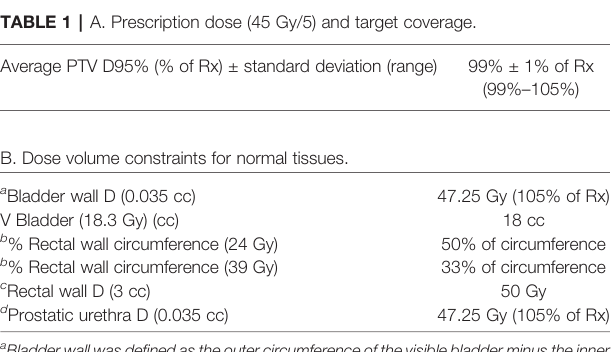
TABLE 1 | A. Prescription dose (45 Gy/5) and target coverage. Average PTV D95% (% of Rx) ± standard deviation (range) 99% ± 1% of Rx